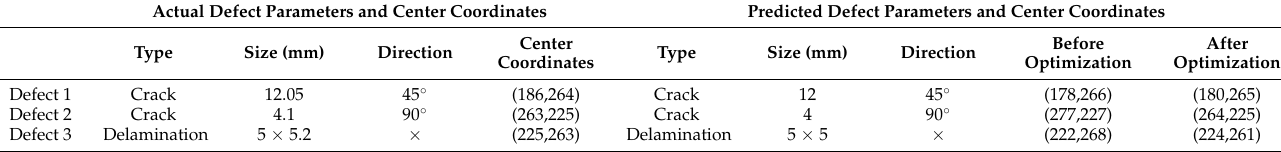
Table 4. Comparison of parameters and center coordinates of three defects before and after optimiza- tion with the actual